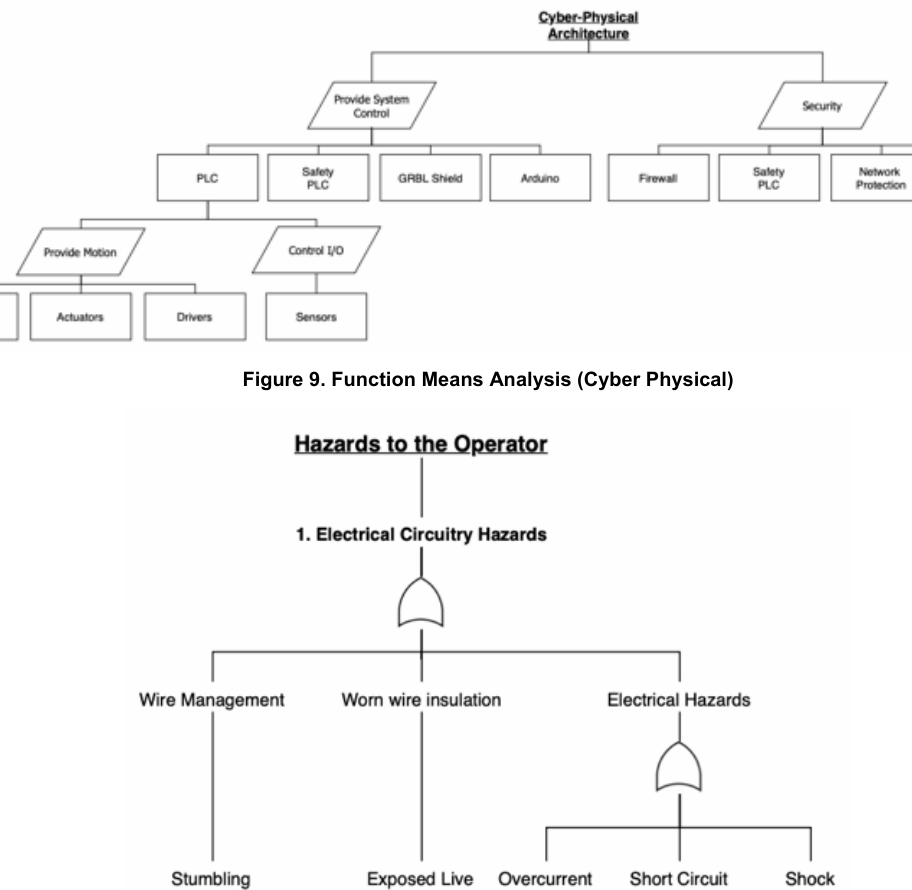
Figure 10. Fault Tree